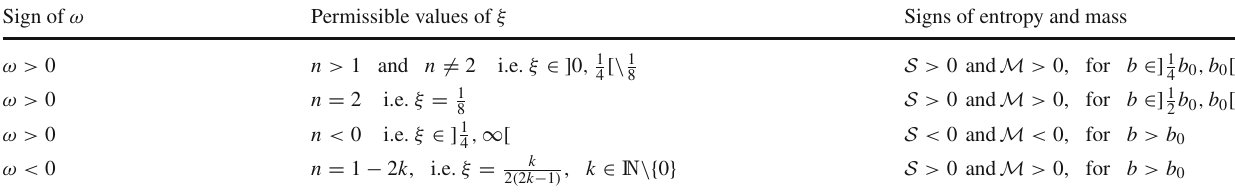
(cid:10) 1 (cid:9) n − 1 n − 1 8 n κ